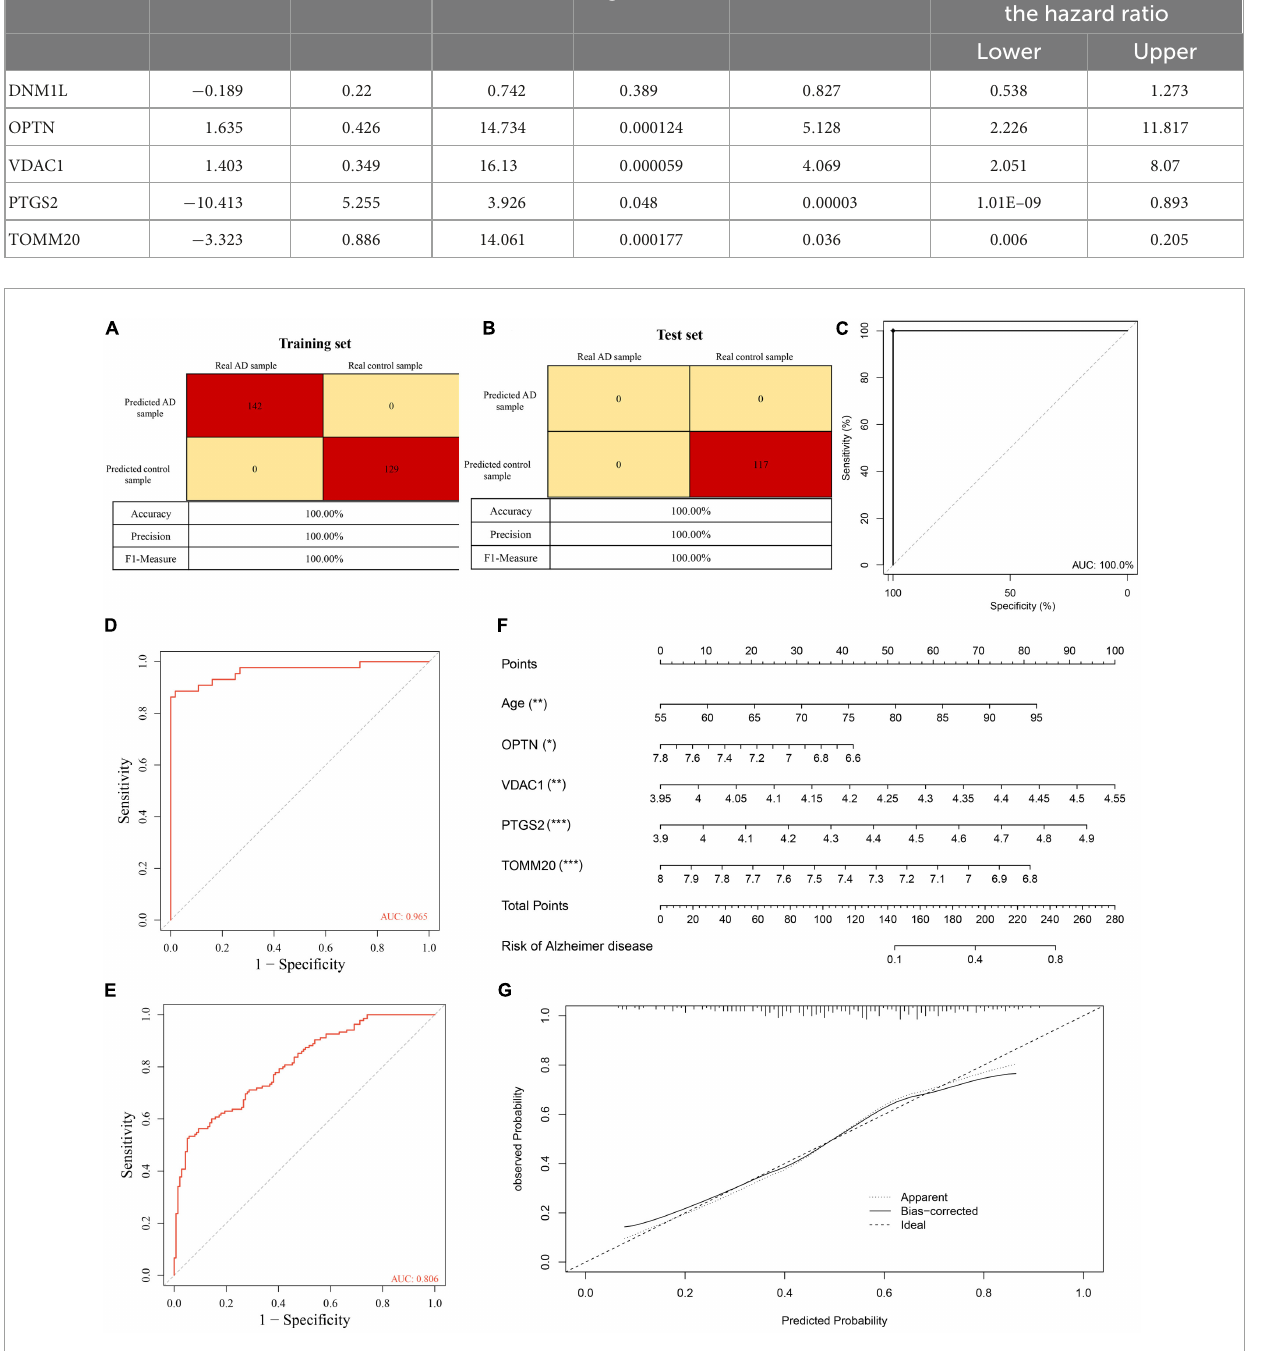
TABLE 2 Univariate analysis of five genes.